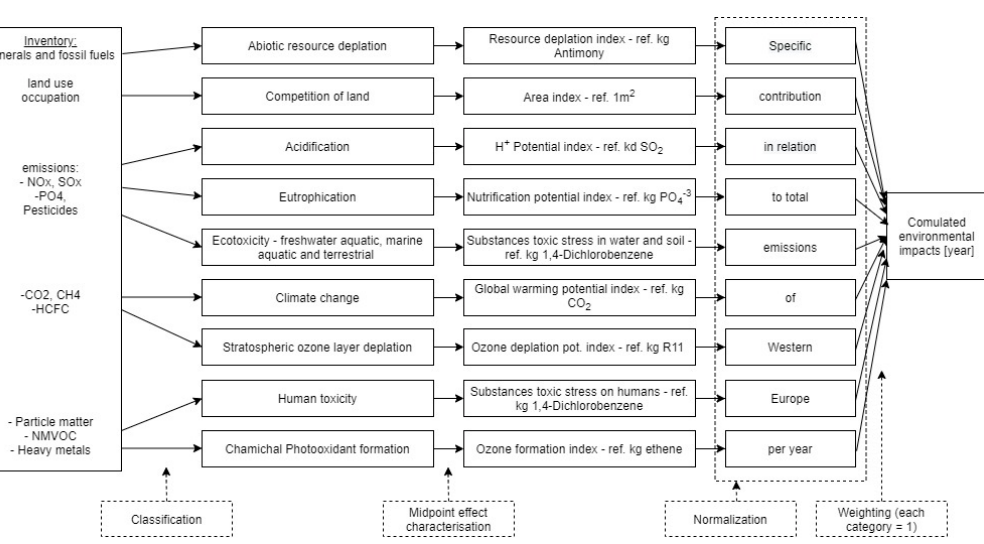
Figure 3. The general structure of the CML 2001 life cycle impact assessment method [28] (the figure was reproduced by the authors)